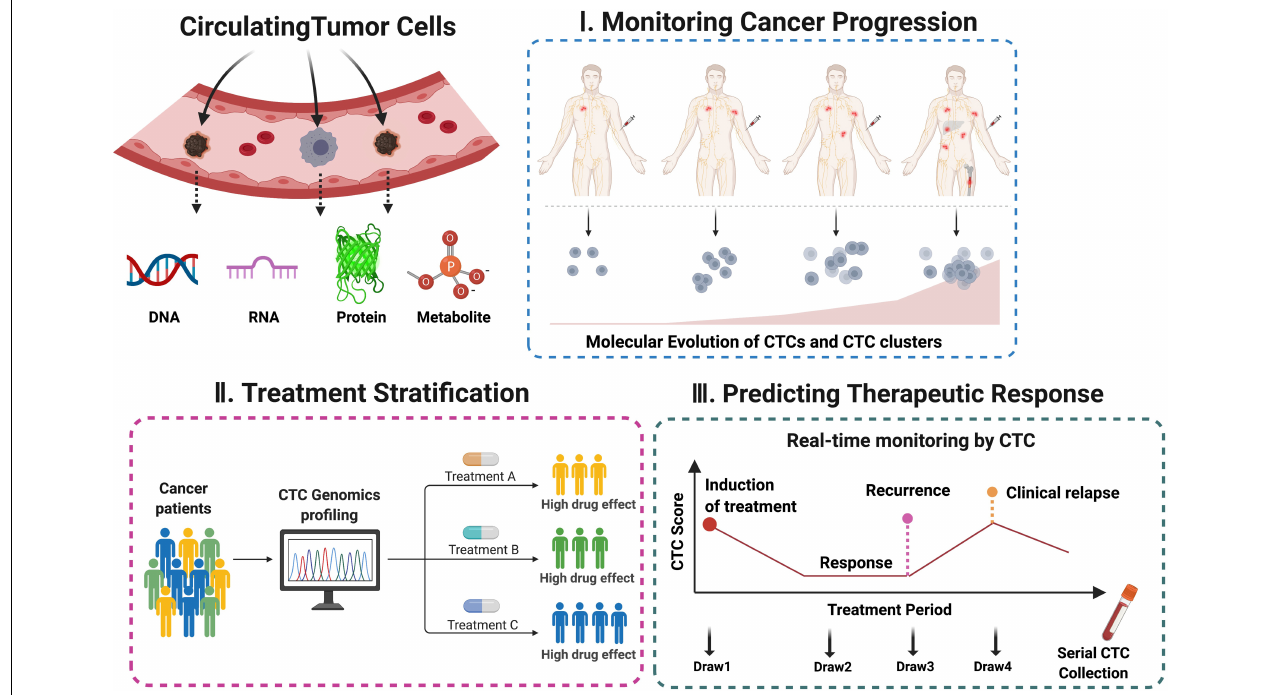
FIGURE 2 | Potential clinical applications using CTC-derived molecular signatures. The molecular and genetic information of CTCs analyzed in a well-defined treatment window may serve as non-invasive biomarker surrogates capable of real-time monitoring of cancer progression, patient stratification, and prediction of long-term clinical